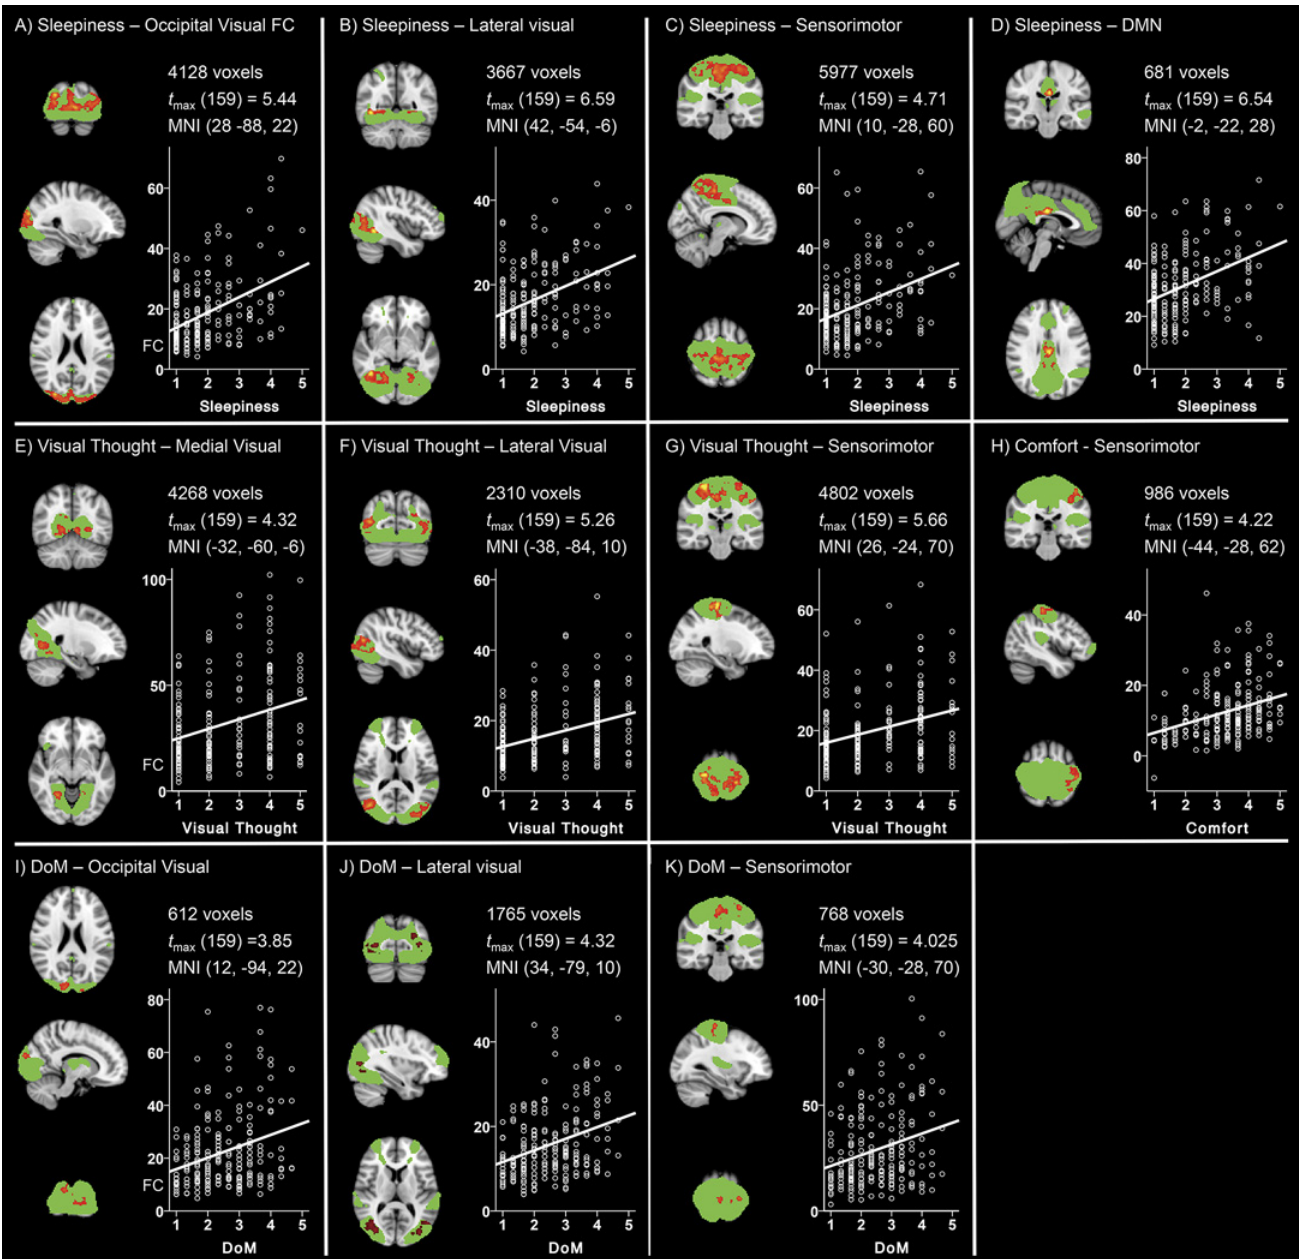
Fig 4. Sleepiness promotes widespread increases in functional connectivity. A total of eleven combinations of ICNs and ARSQ dimensions showed significant associations between functional connectivity and ARSQ score at a cluster-wise Bonferroni-corrected significance threshold of P FWE = .00025. Orthogonal slices through the peak voxel are shown on the left of each panel; ICNs are defined by the ICA spatial maps thresholded at Z = 2.3 and displayed in green, clusters of voxels showing significant associations (2.62 < t < 6) in a gradient from red to yellow, overlaid on a standard brain template in radiological convention (left = right). Number of significant voxels, maximum t -statistic and peak voxel coordinates are displayed at the top right, scatter plots showing the mean functional connectivity value in significant clusters (y-axis) plotted against the relevant ARSQ measure are shown in the bottom right of each panel.